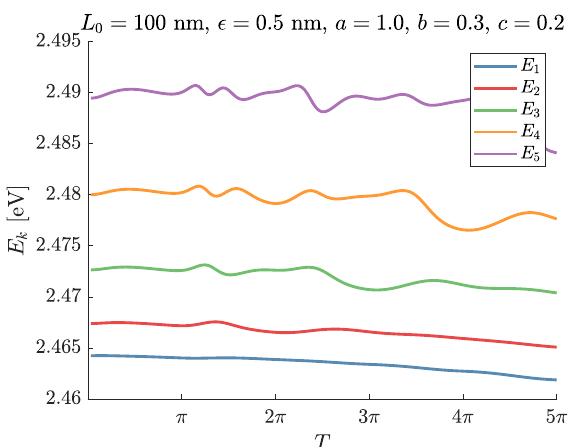
Figure 6. Energies for the elliptic helix with length 10nm and constant width 1nm.